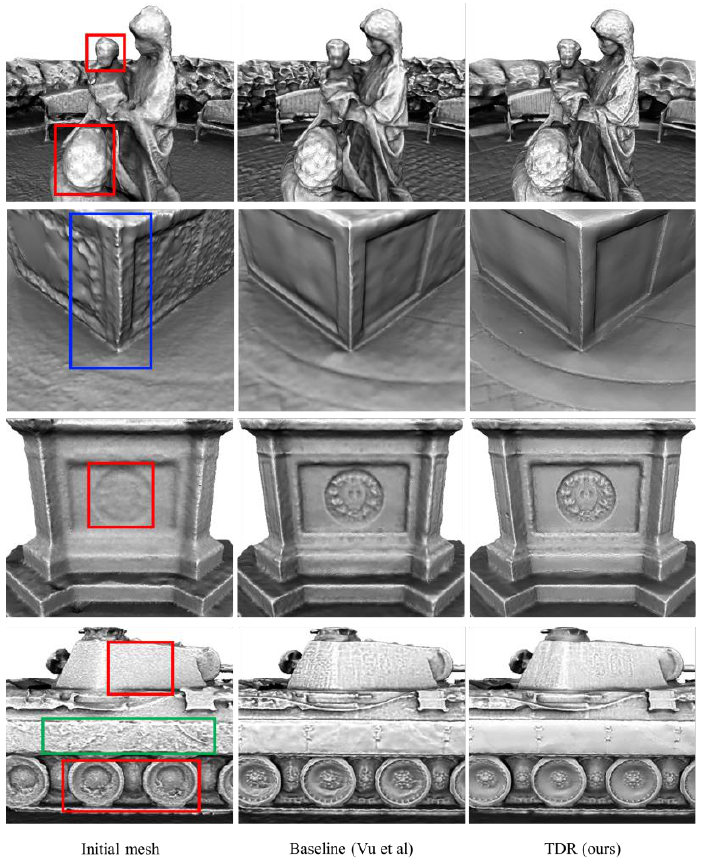
Figure 9. Visual comparison of results on the Tanks and Temples dataset.